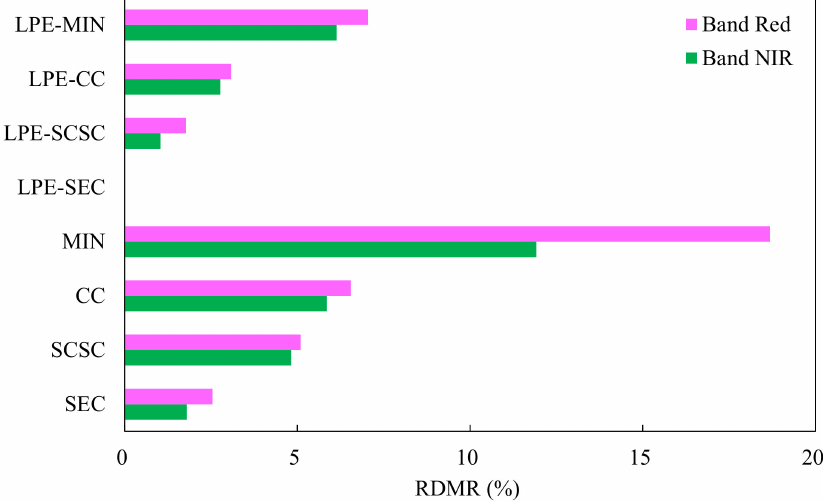
Figure 4. The comparison of RDMR between the traditional TC models and the TC models with